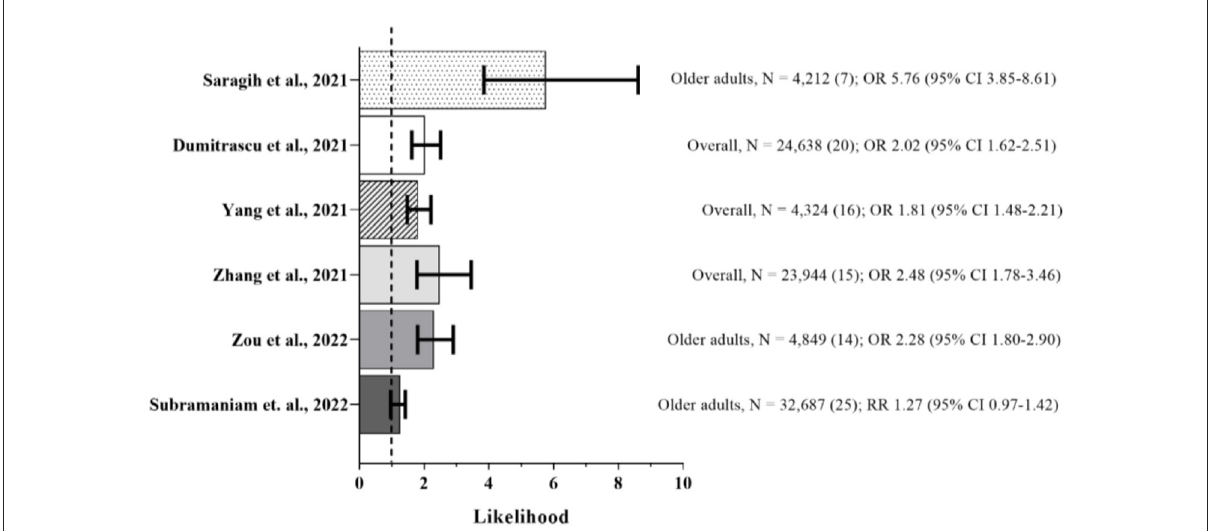
FIGURE1 Frail vs. Non-frail Short-term Mortality. Sample, number of participants (number of studies in the meta-analysis), and likelihood of event (95% confidence interval, CI). Summary of the mortality risk outcome from meta-analyses (15, 16, 24, 51–53). Dashed line represents absence of statistical significance. Frailty was predominantly assessed by clinical frailty scale